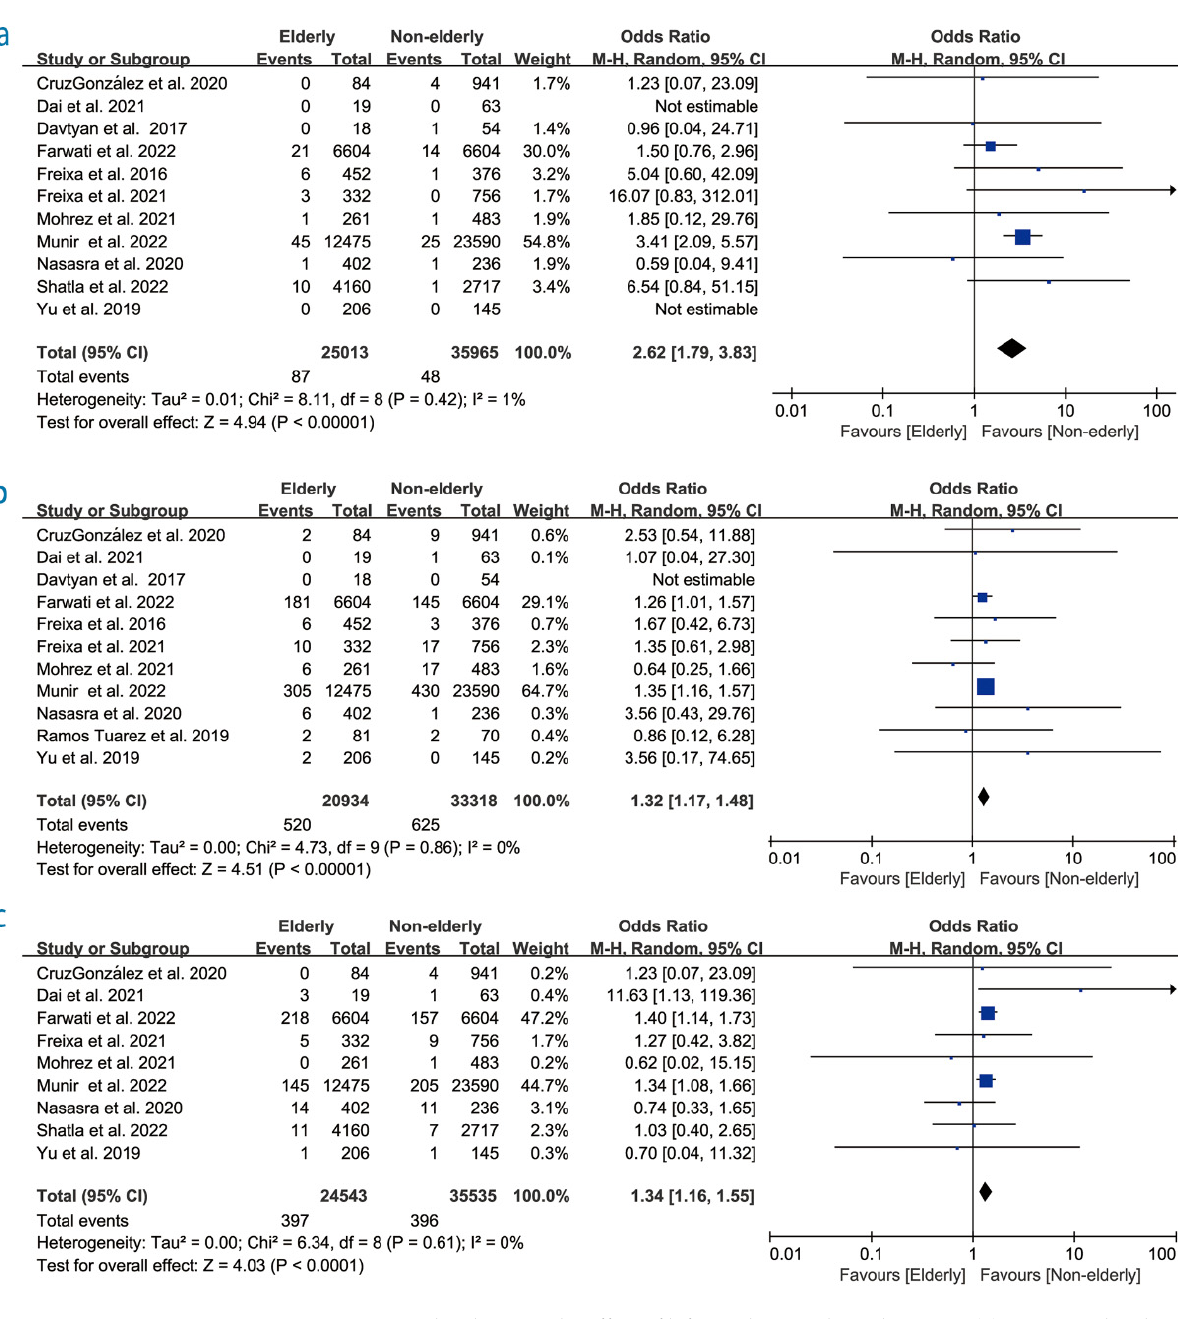
Figure 3. Forest plot showing the effect of left atrial appendage closure on ( a ) periprocedural mortality, ( b ) major bleeding events, and ( c ) vascular access complication [14–17,20–27].